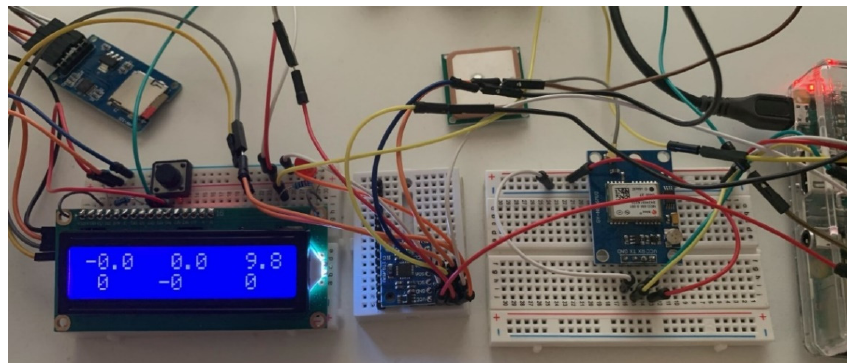
Figure 5. Assembled system.